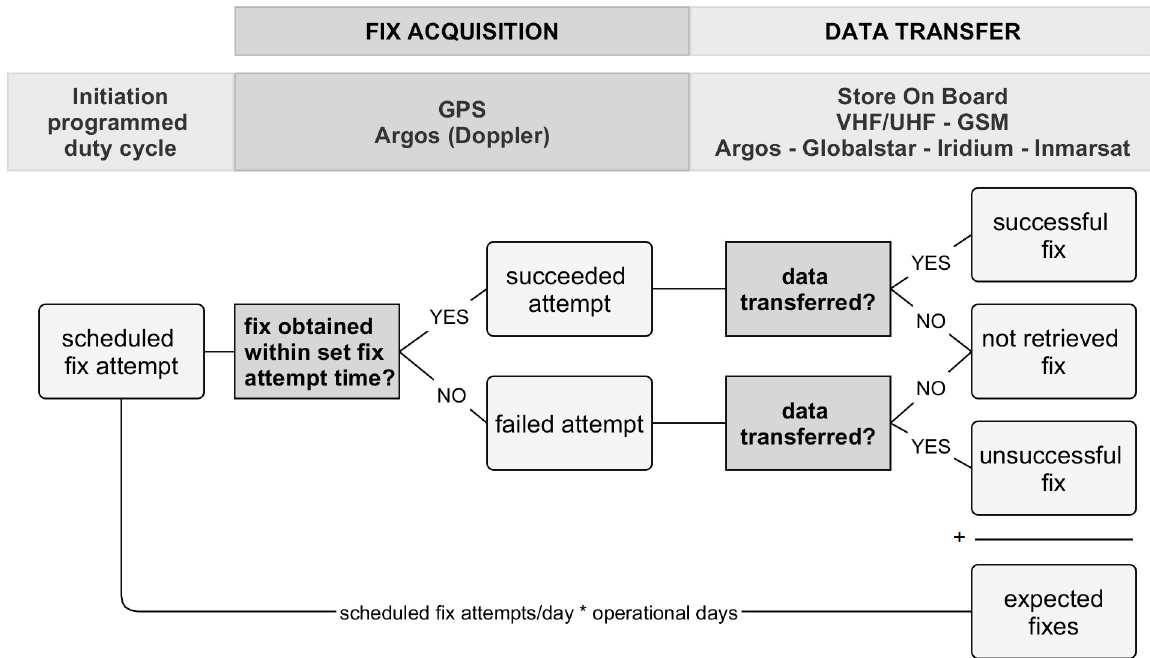
Fig 1. Two-step satellite telemetry process. The general two-step operation of terrestrial satellite telemetry units, and the possible fix outcomes of the process. The number of expected fixes equals the sum of successful, unsuccessful and not-retrieved fixes (see Materials and methods).